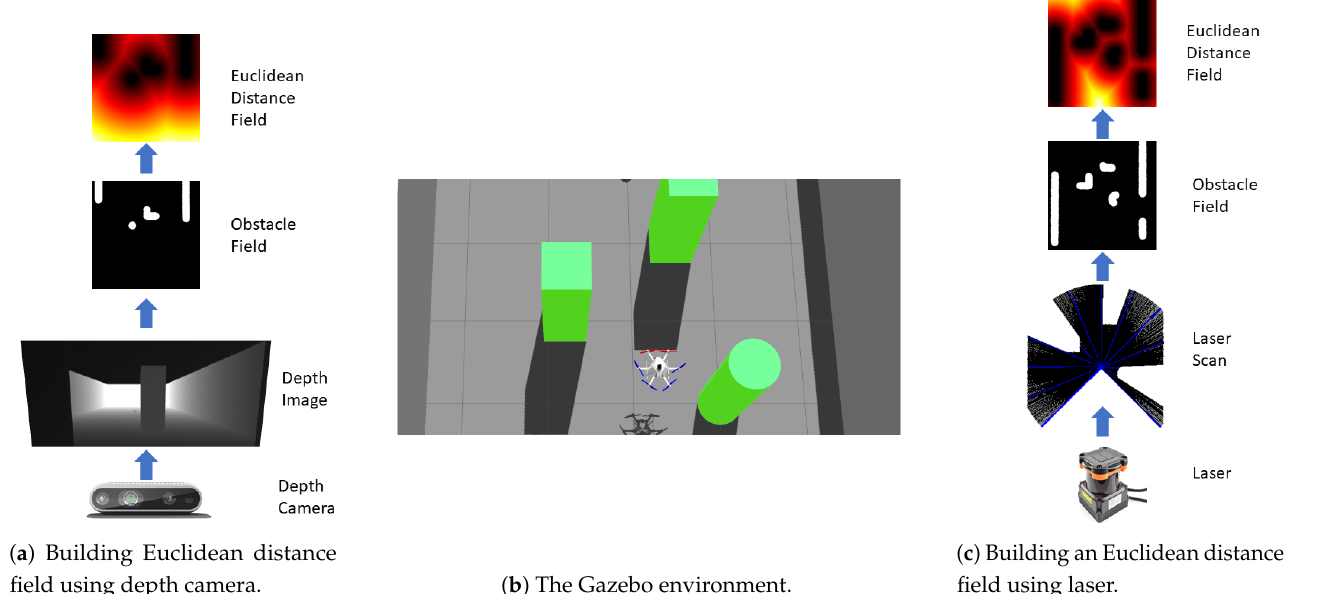
Figure 2. The Euclidean distance field generation process using the information provided by the depth